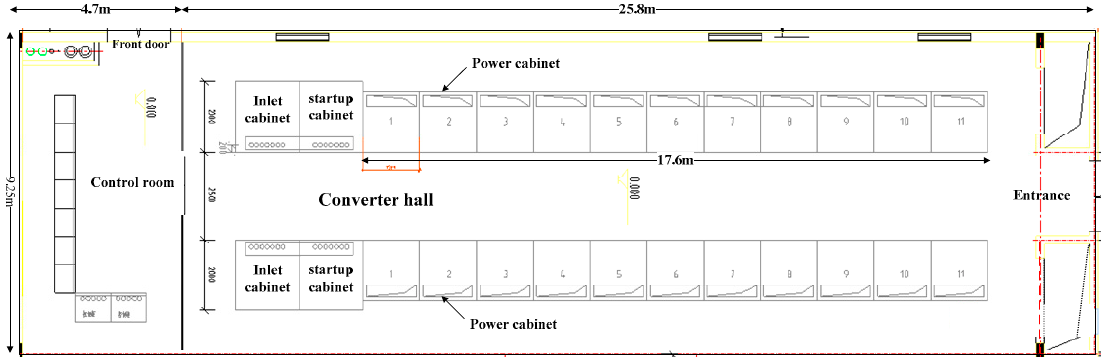
Figure A1. Floorplan of 100 Mvar SVG room in 500 kV Chuanshan substation. Electronics 2018 , 7 , x FOR PEER REVIEW